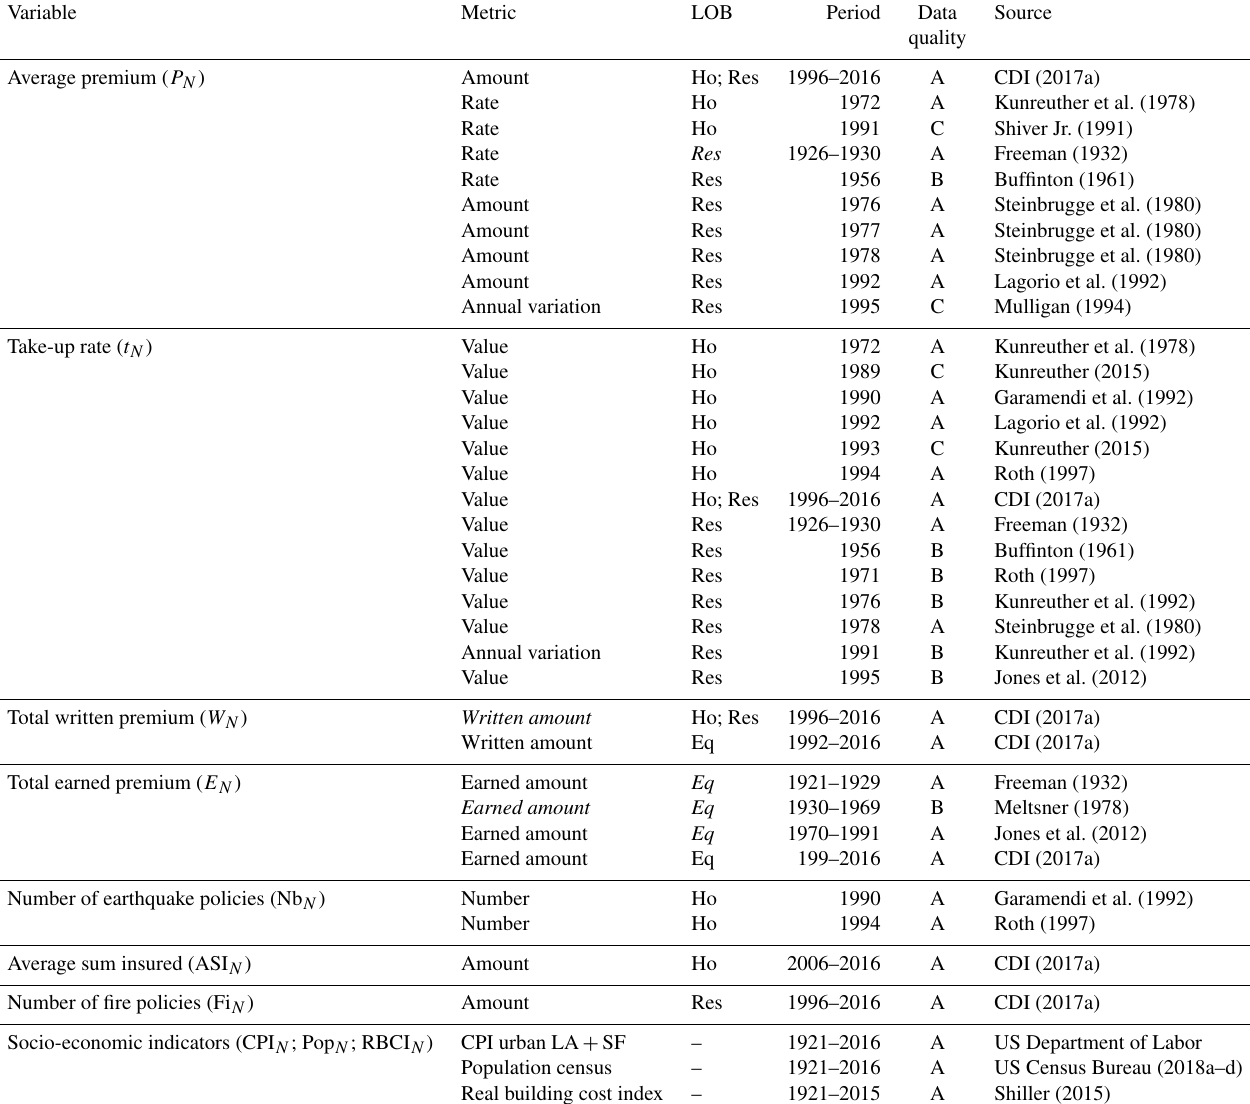
Table 1. Raw data collected about earthquake insurance. Labels in italic are not extracted from publications but have been inferred by cross- checking with other sources. The data quality scale is A (good): scientific publication with methodology explained; B (acceptable): scientific publication without details on the methodology; C (weak): mass media. CPI: consumer price index; Eq: earthquake; Ho: